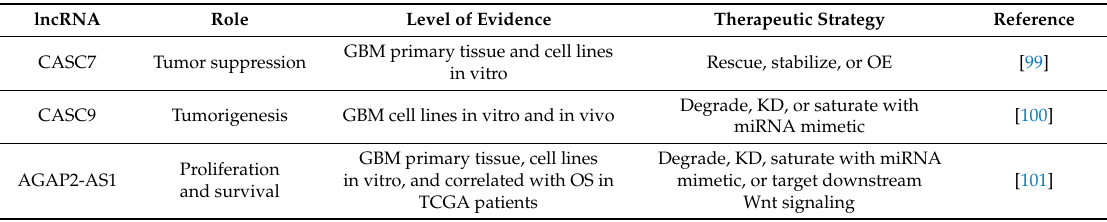
Table 1. lncRNAs in glioblastoma